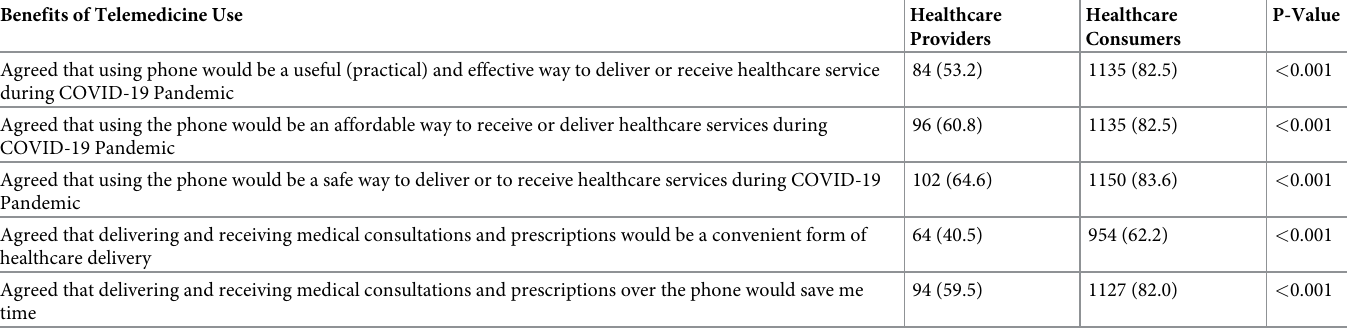
Table 4. Comparison of healthcare providers and healthcare consumers perceptions on benefits of telemedicine